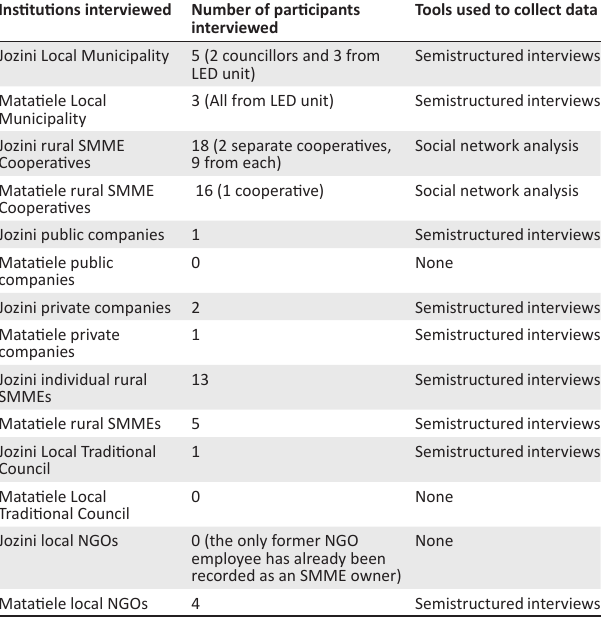
TABLE 2: Details of participants and tools used in this